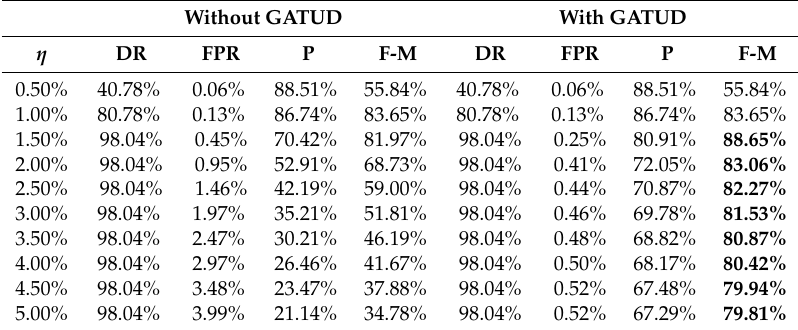
Table 3. The separation accuracy of abnormal observations with/without GATUD on SimData1. Without GATUD With